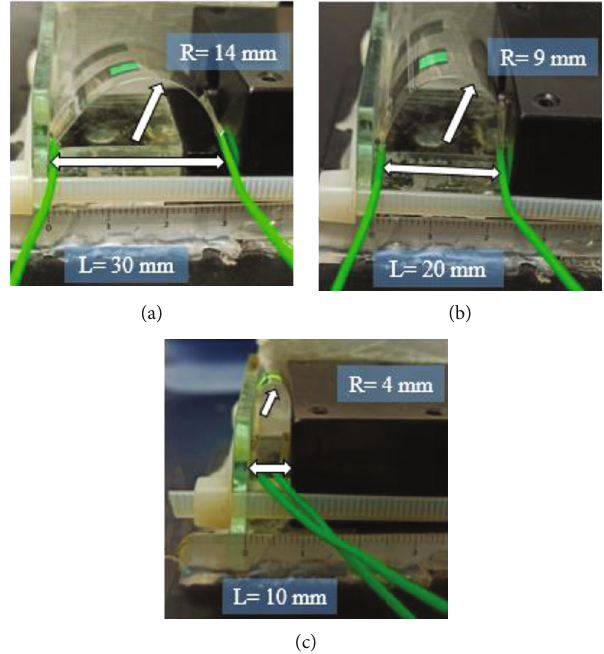
Figure 3: Flexibility test of TE-OLED substrates at a length of (a) L = 30 mm , (b) L = 20mm , and (c) 10mm.